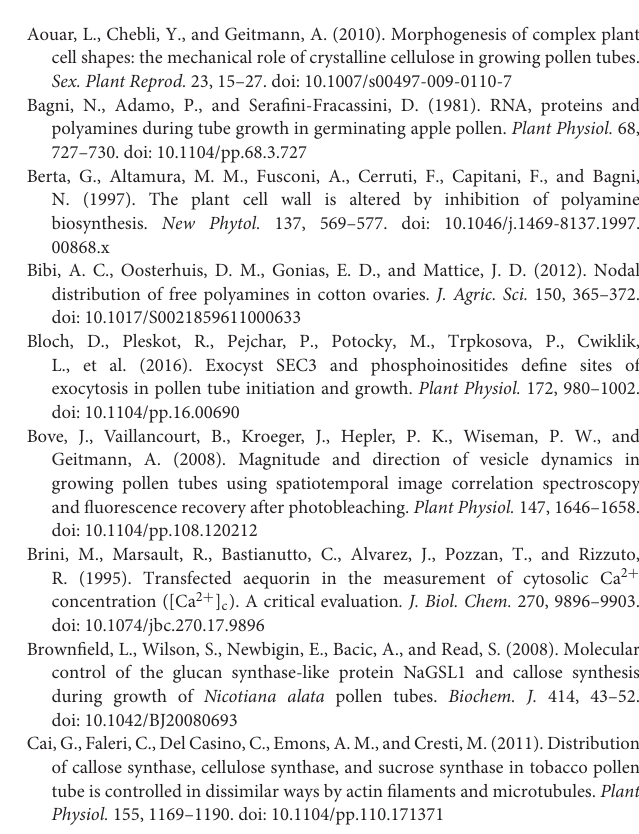
“a” are significantly different from controls based on Tukey’s multiple comparison test at P < 0.05. Supplementary Figure 1 | Physiological and progressive decrease of pollen viability during in vitro germination (A) and concomitant increase in the basal [Ca 2 + ] cyt (B) . Supplementary Figure 2 | (A) Apical region of control pollen tube (a) or pollen treated with 100 µ M La 3 + (b) , 100 µ M Gd 3 + (c) , or 1mM EGTA (d) showing no changes in external morphology. Bars: 10 µ m. (B) Pretreatment with La 3 + , Gd 3 + , or EGTA counteracts, in a dose-dependent manner, the extension of the shovel-shaped apical region. (a) Pollen treated with 100 µ M Spm only. (b–d) Pollen pretreated with 10, 25, and 50 µ M La 3 + 20min prior to Spm supplementation. (e–g) Pollen pretreated with 10, 25, and 50 µ M Gd 3 20min prior to Spm supplementation. (h,i,l) pollen pretreated with 200, 400, and 1,000 µ M EGTA 20min prior to Spm supplementation. Bars: 30 µ m. Supplementary Figure 3 | Morphological and growth data of pollen tubes treated with spermine and microtubule inhibitors (taxol and oryzalin). (A) Diameter of control pollen tubes (i.e., without microtubule inhibitors) and of pollen tubes treated with taxol/oryzalin as measured before and after addition of spermine (Spm). (B) Growth rate of control pollen tubes (without microtubule inhibitors) and of pollen tubes treated with taxol/oryzalin as measured before and after addition of Spm. Asterisks indicate statistically comparable differences before and after addition of Spm. Supplementary Figure 4 | (Left column) Labeling of pear pollen tubes with JIM7 antibody against high methyl-esterified pectins; (Right column) Labeling of pear pollen tubes with JIM5 antibody against low methyl-esterified (acidic) pectins. (A,B) control pollen tubes; (C,D) Spm-treated pollen tube at the balloon stage; (E1,E2,F) Spm-treated pollen tube at the shovel stage. Bars: 10 µ